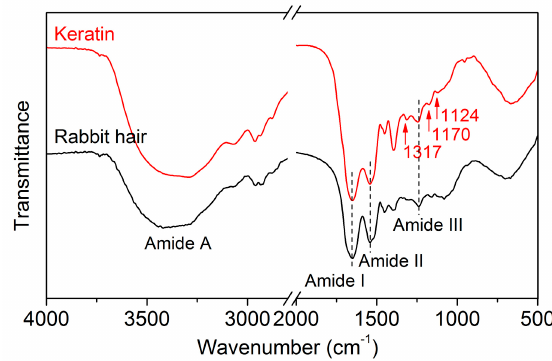
Figure 7. FT-IR spectra of rabbit hair and regenerated keratin by dissolving in DES at 120 °C.